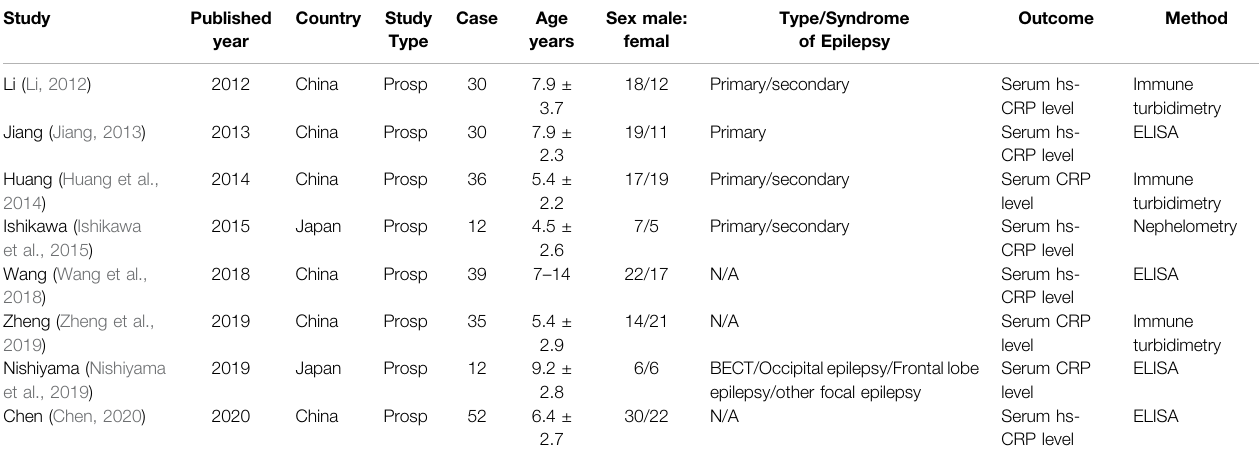
BECT: benign epilepsy of childhood with centrotemporal spikes.